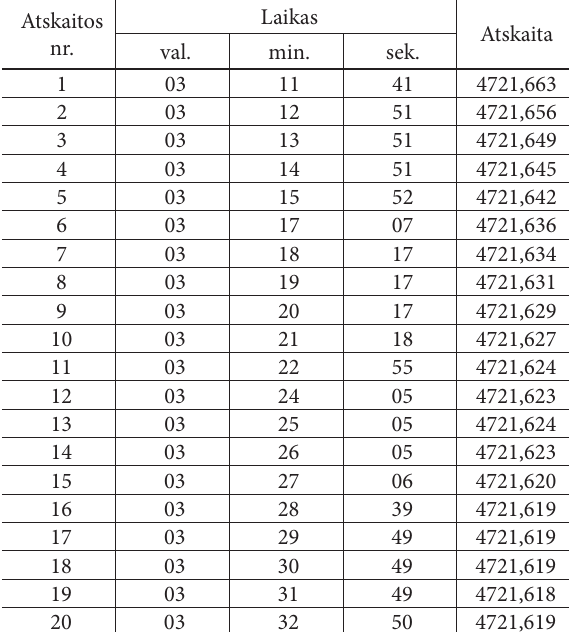
Fig. 3 . Differences in the reduced readings (G3-G4,